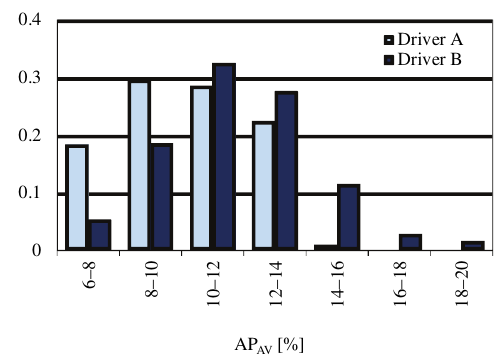
Fig. 22. Average relative position of accelerator pedal in urban driving conditions